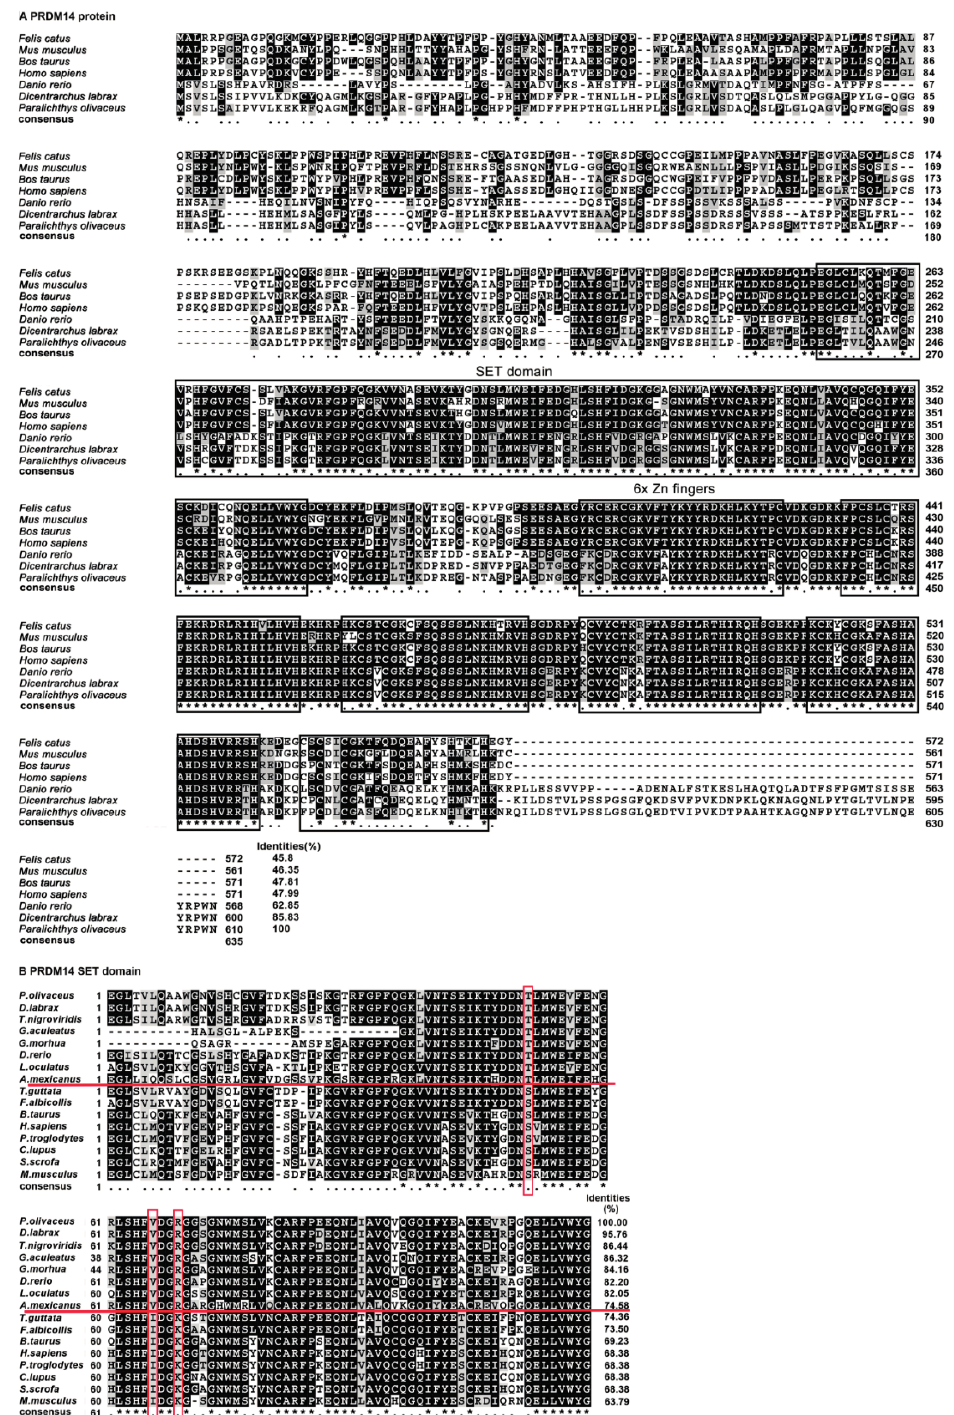
Figure 3. ( A ) Multiple alignment of full-length PRDM14 amino acid sequences in different species. The conserved SET domain is marked with a black frame. The identity scores relative to the Japanese flounder sequence are shown on the right; ( B ) SET domain protein sequence alignment of Po -PRDM14 with other vertebrate orthologs. Identity scores relative to the Japanese flounder SET domain sequence are shown on the right. The alignment is generated with the CLUSTALW and shaded with BOXSHADE 3.21. Identical ( * ) and similar (.) amino acid residues are indicated. The conserved positions in teleosts are marked with a red frame. The fish and tetrapod species are separated by a red